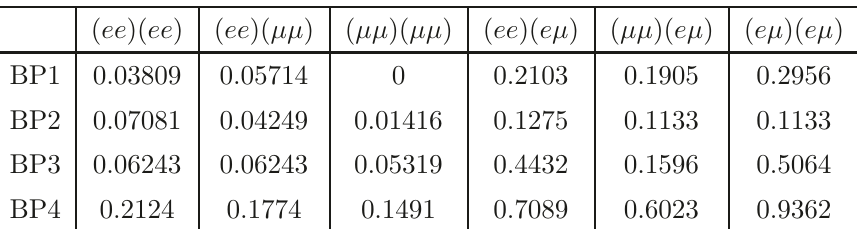
Table 7. Flavour composition of 4-displaced leptons in the